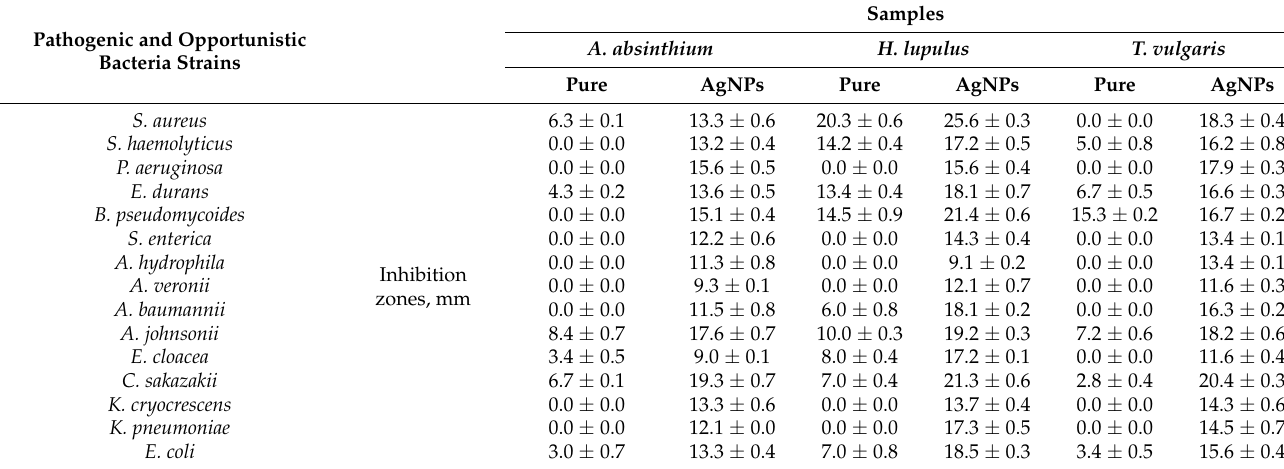
Table 3. Inhibition zones of the extracts against pathogenic opportunistic microorganisms. Pathogenic and Opportunistic Bacteria